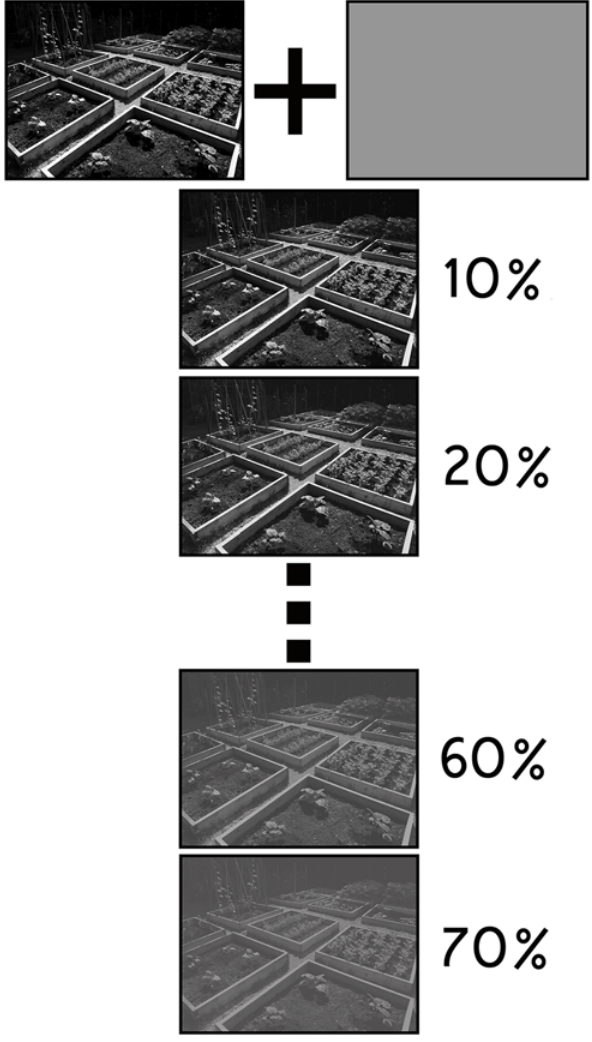
Fig 1. Scene Degradation. Illustration of the approach that was used to systematically degrade scenes that were presented in the subliminal masking sequences. A gray layer (R: 115, B: 113, G: 113) was superimposed on top of each scene. The opacity of this layer was then systematically increased to produce a set of nine additional scene exemplars that were used in a norming experiment. Scenes carried forward for use in the experiment proper were selected based on the outcome of the norming